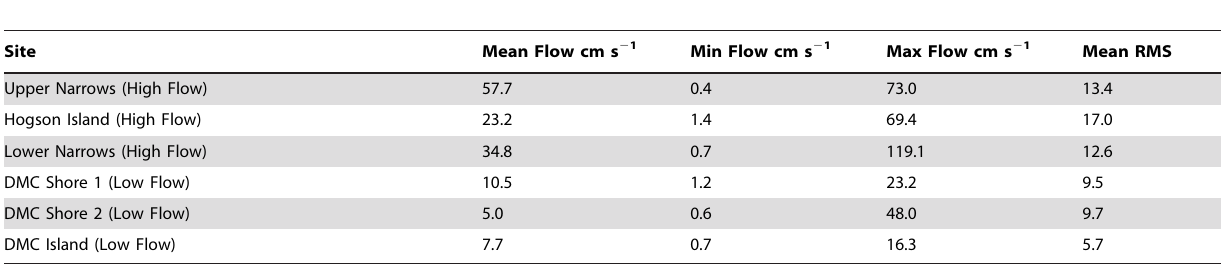
Table 1. Hydrodynamic conditions measured in 6 field sites in the Damariscotta River, ME, USA.